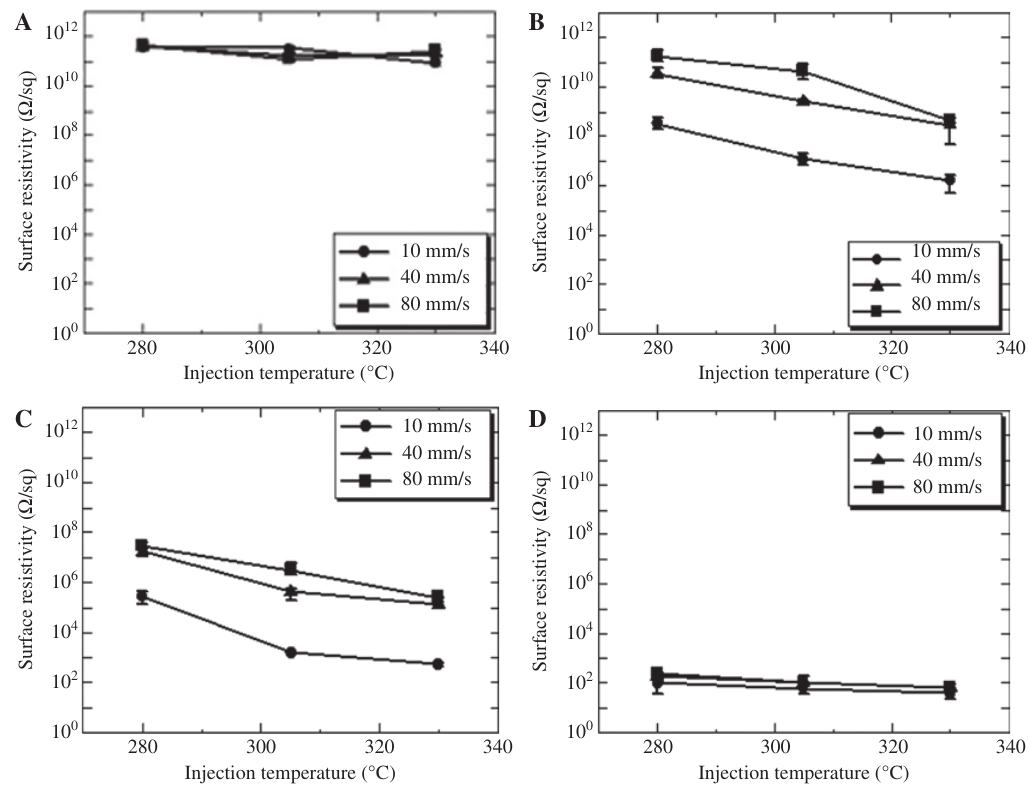
Figure 9: Effect of injection temperature on surface resistivity of the MWCNT/PC composites with (A) 1 wt.% MWCNTs, (B) 2.5 wt.% MWCNTs, (C) 5 wt.% MWCNTs, and (D) 10 wt.% MWCNTs.